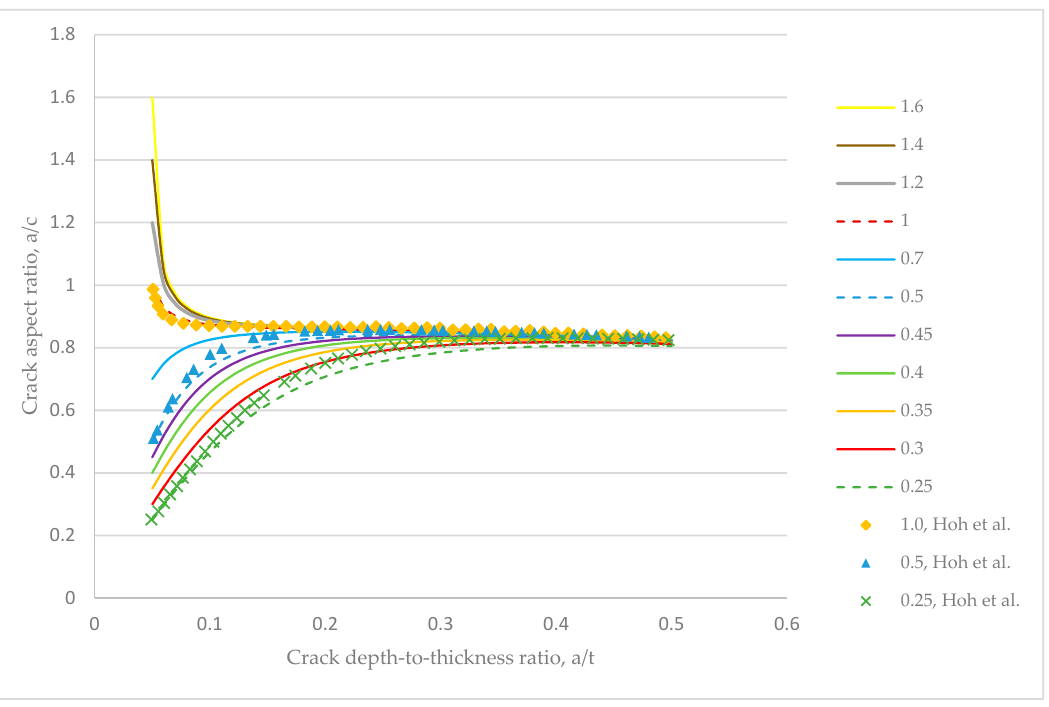
Figure 18. Change in aspect ratio with relative crack depths for external surface cracks in a pipe under tension showing the final aspect ratio convergence. The legend indicates the initial crack aspect ratio values.